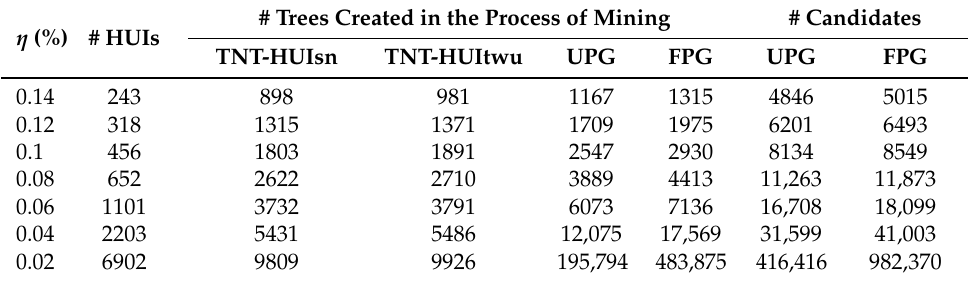
Table 9. Details analysis on the dataset retail.